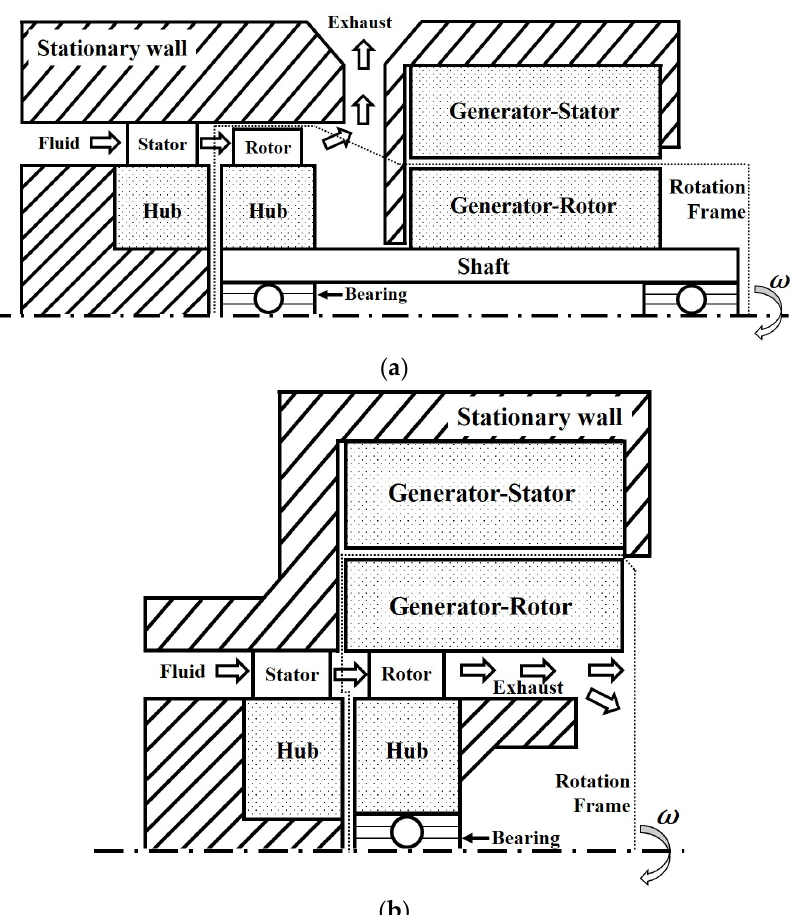
Figure 2. Turbine generator structure in the ORC system. ( a ) Conventional type: The generator rotor is rotated using the turbine rotor torque through the shaft. ( b ) Proposed turbine embedded in a generator (TEG) type. The generator rotor is rotated using the rotation of the turbine rotor without a shaft.